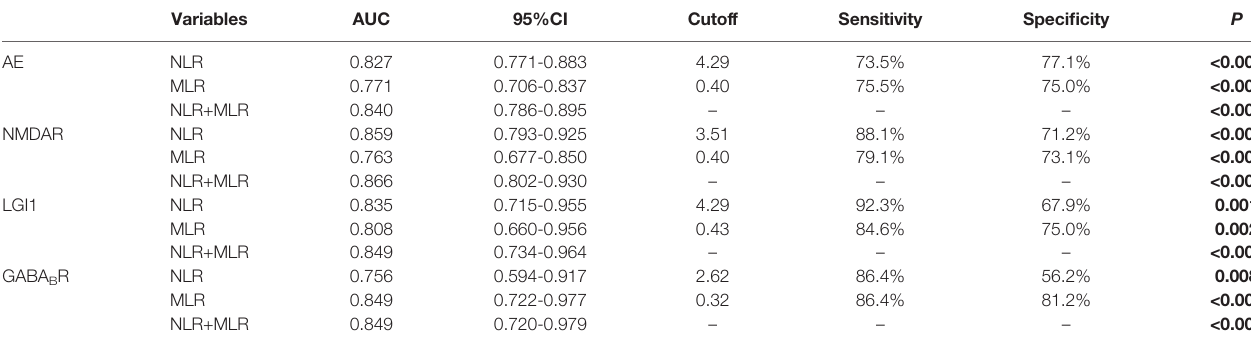
TABLE 3 | Receiver operating characteristic curve of NLR and MLR for the severity of AE.